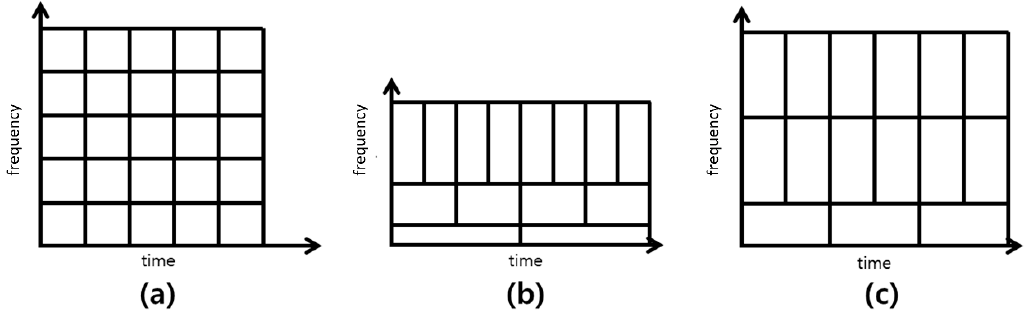
Figure 2. Window shapes: ( a ) short-time Fourier transform (STFT); ( b ) wavelet transform (WT); ( c ) wavelet packet decomposition (WPD).